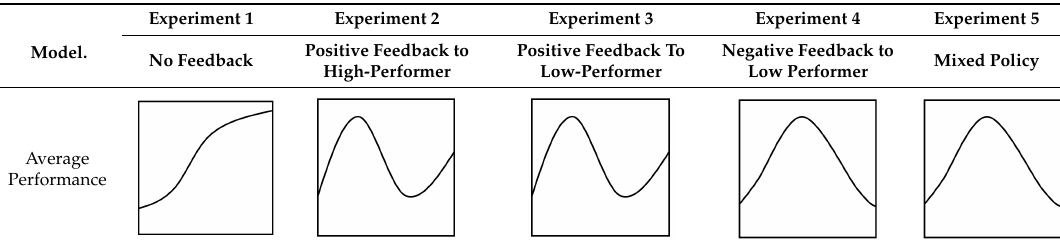
Table 7. Summation of the simulation results.